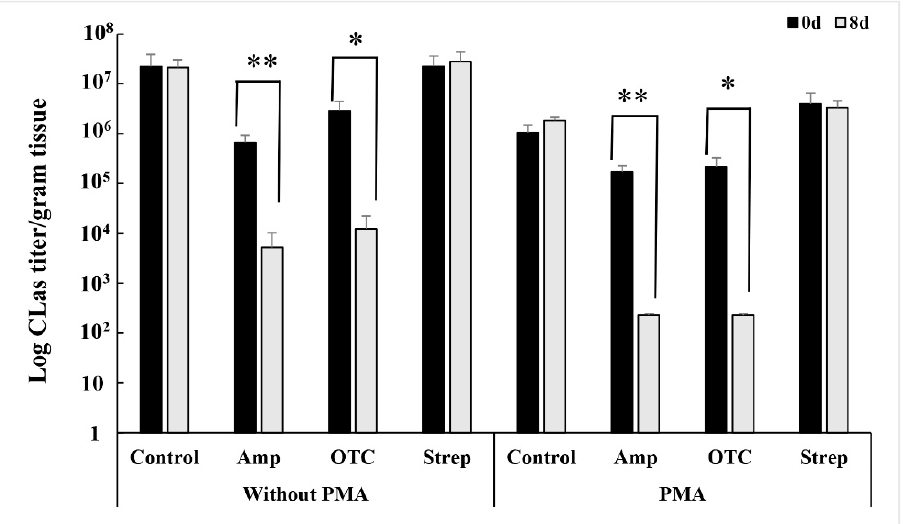
Figure 4. Assessing antibacterial activity of chemical compounds (Amp, OTC, Strep, and water control) against CLas via PMA ‐ qPCR in HLB ‐ affected citrus cutting assays. Significant differences between time points are indicated by * p ≤ 0.05 and ** p ≤ 0.01. Standard error of the mean is indicated by a vertical line.